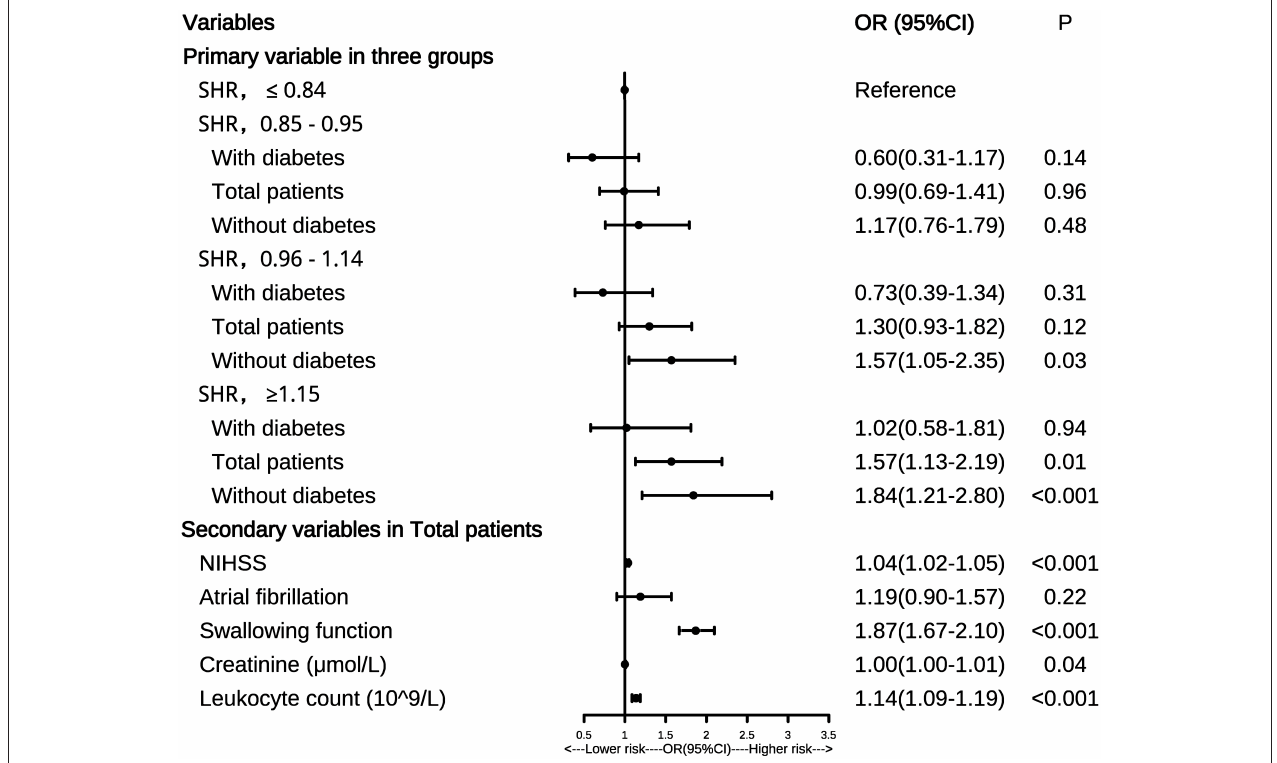
FIGURE 1 | Forest plot of odds ratios for SAP. NIHSS, National Institutes of Health Stroke Scale; SAP, stroke-associated pneumonia; OR, odds ratio; 95%CI, 95% confidence